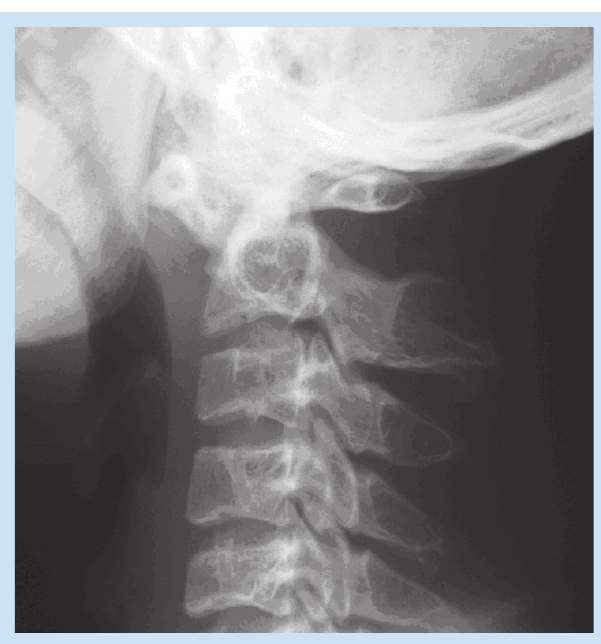
Fig. 1. Lateral neck view demonstrating an atlantodental interval (ADI) of 11 mm compared to the normal for adult males of up to 3 mm. Well-corticated bony ossicles are visualised superior and inferior to the anterior arch. The dens is small and the posterior arch of C1 is displaced anteriorly. The spinal canal is reduced in diameter.